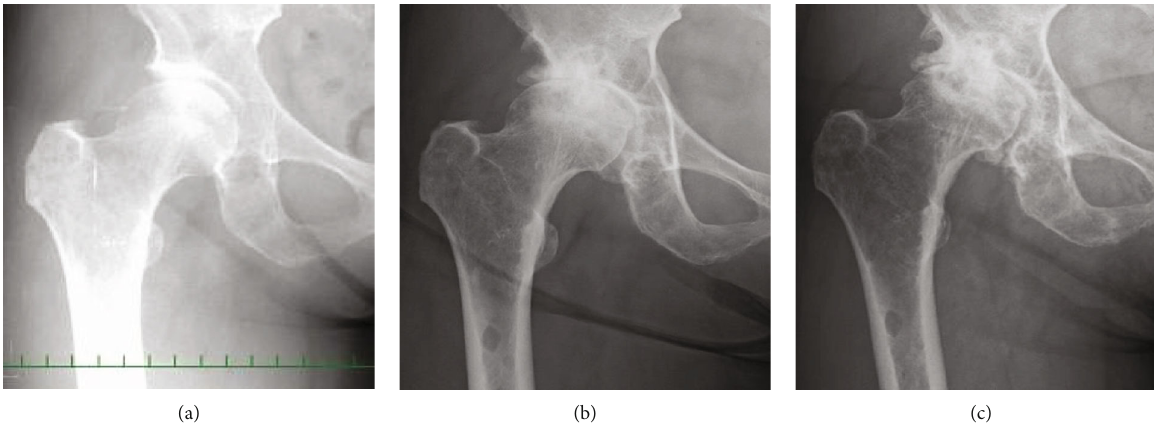
Figure 1: Plain radiographs, (a) 13 years prior to surgery, (b) 2 years prior to surgery, and (c) 1 month prior to surgery, reveal progression of arthritic changes including loss of joint space and femoral head cyst. Acetabular dysplasia with a center-edge angle of 13 degrees and sharp angle of 47 degrees, osteoarthritis with loss of joint space and bone cysts in the femoral head, and multiple myeloma with punched-out lesions are depicted.